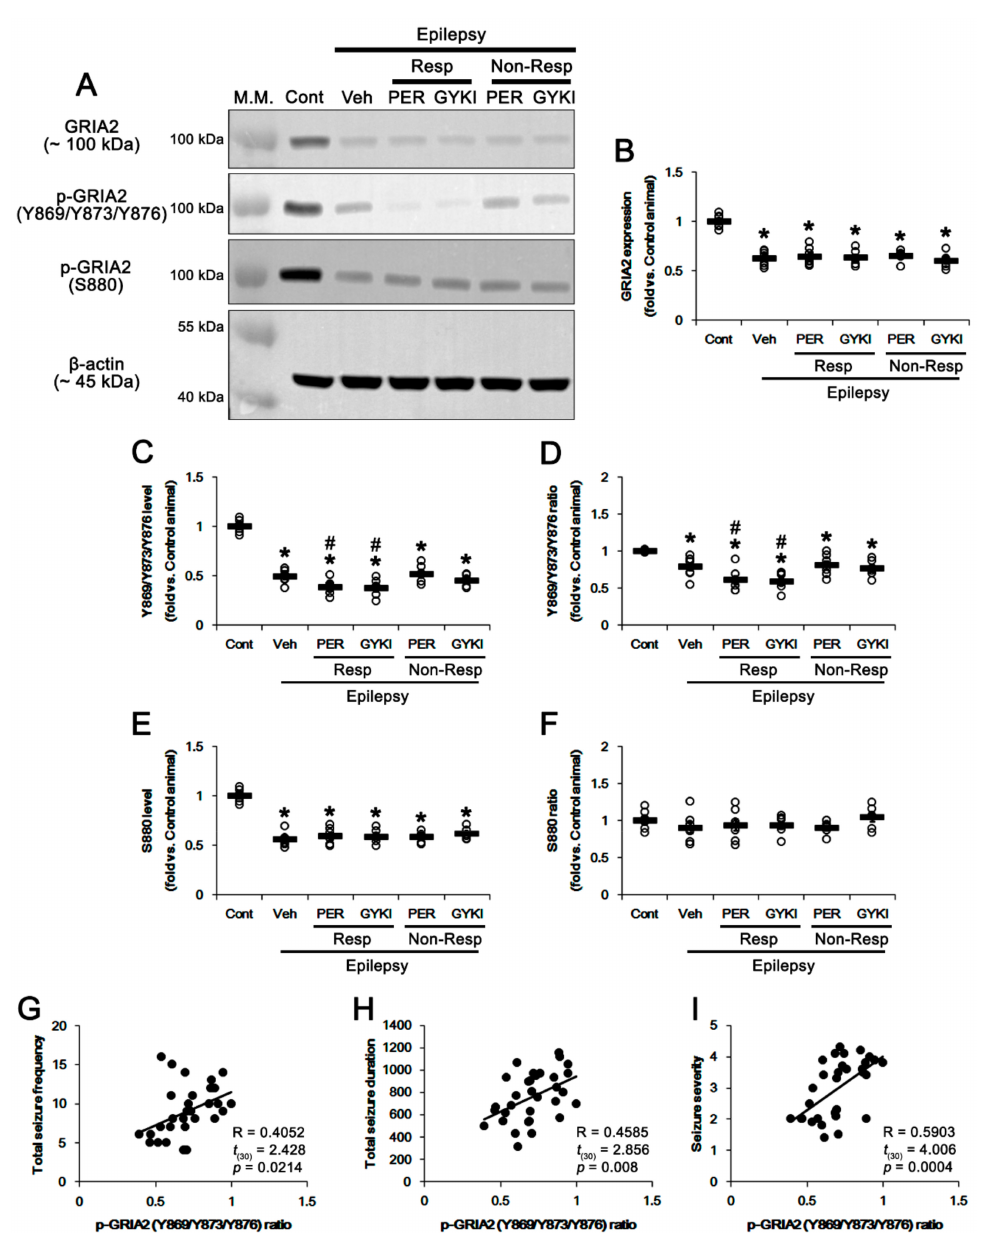
Figure 3. The effects of perampanel (PER) and GYKI 52466 (GYKI) on total glutamate ionotropic receptor AMPA type subunit 2 (GRIA2) expression and its phosphorylations in chronic epilepsy rats. ( A ) Representative images for Western blot of GRIA2 and its phosphorylation levels in the hippocampal tissues. ( B – F ) Quantifications of GRIA2 ( B ), p-GRIA2 Y869/Y873/Y876 ( C ), p-GRIA2 Y869/Y873/Y876/GRIA2 ratio ( D ), p-GRIA2 S880 ( E ), and p-GRIA2 S880/GRIA2 ratio ( F ) in the hippocampal tissues. Open circles indicate each individual value. Horizontal bars indicate mean value. Error bars indicate SEM ( *, # p < 0.05 vs. control (Cont) and vehicle (Veh)-treated animals, respectively; one-way ANOVA with post hoc Bonferroni’s multiple comparison). ( G – I ) Linear regression analyses between p-GRIA2 Y869/Y873/Y876/GRIA2 ratio and total seizure frequency ( G ), total seizure duration ( H ), and seizure severity ( I ) in chronic epilepsy